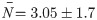
A metapopulation can form when the population is below the expansion threshold throughout its range.The population fragments rapidly (within tens of generations) to small patches of tens to a few hundred individuals whilst losing local adaptive variation. In two-dimensional habitats, such a metapopulation with limited adaptation can persist for a long time. Nevertheless, the population very slowly contracts, eventually forming a narrow band adapted to a single optimum. (a) The distribution of phenotypes across space is fragmented. (b) The subpopulations are transient, although they are stabilised by dispersal across space, especially along the neutral direction with no change in the optimum (Y). Locally, the population density may be higher than under uniform adaptation; blue contours depict the deterministic prediction for population density under uniform adaptation, N = 3. The realised density is about N¯=3.05±1.7 (standard deviation); darker shading represents higher density. (c) The adaptive genetic variance is low on average (VG¯=0.02±0.06)—about an order of magnitude lower than would be maintained by gene flow under uniform adaptation (shown in green contours, VG = 0.23). Typically, only a few clines in allele frequencies contribute to the genetic variance within a subpopulation. The parameterisation and predictions are detailed in the Individual-based simulations section of the Methods; predicted neighbourhood size is N^=2.7, effective environmental gradient is B = 0.48. Shown here after 5000 generations—the population collapses to a narrow band (at X = 45) after a further 20,000 generations and then appears persistent.